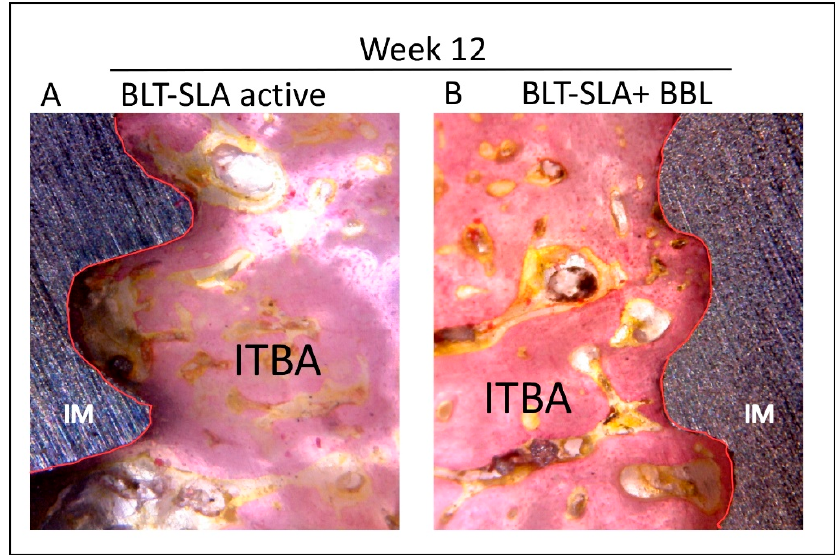
Figure 4. Representative image illustrating the inter-thread bone area (ITBA) generated at week 12 post-implantation. ( A ). Control group, BLT-SLA active implant. ( B ). Test group, BLT-SLA pre- treated with BBL. At the week-12 assessment, new ITBA is generated in the test group, but SLA active showed sustained bone remodeling around the threads’ pitch and valley. IM = implant. Mag- nification 24×.